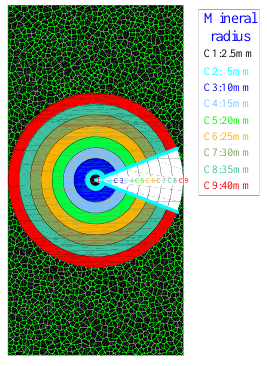
Figure 8. Mineral radii. 254